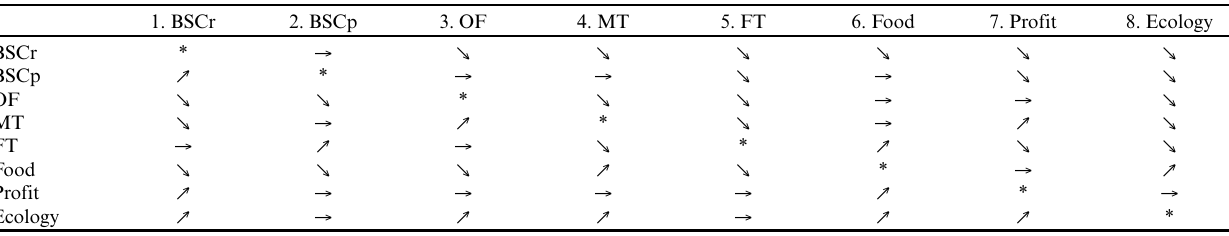
Table 3 . Trade-offs present in the model. BSCr: beach seine crew well-being; BSCp: beach seine captain well-being; OF: other fishers well-being; MT: male traders well-being; FT: female traders well-being; Food: overall food security; Profit: overall profitability; Ecology: overall ecological integrity. Each column represents the optimization of one outcome variable of the toy-model (eight in total). Read by columns from to top to bottom. A star represents a variable that is being optimized in a given column. Arrows up represent a synergetic effect between a given pair of variables. Arrows down represent a trade-off. Sideways arrow represents no relationship. For example, in column 1, as we optimize for maximum beach seine crew well-being (BSCr), the well-being of “beach seine captain” increases while the well-being of “other fishers” (OF) decreases and so